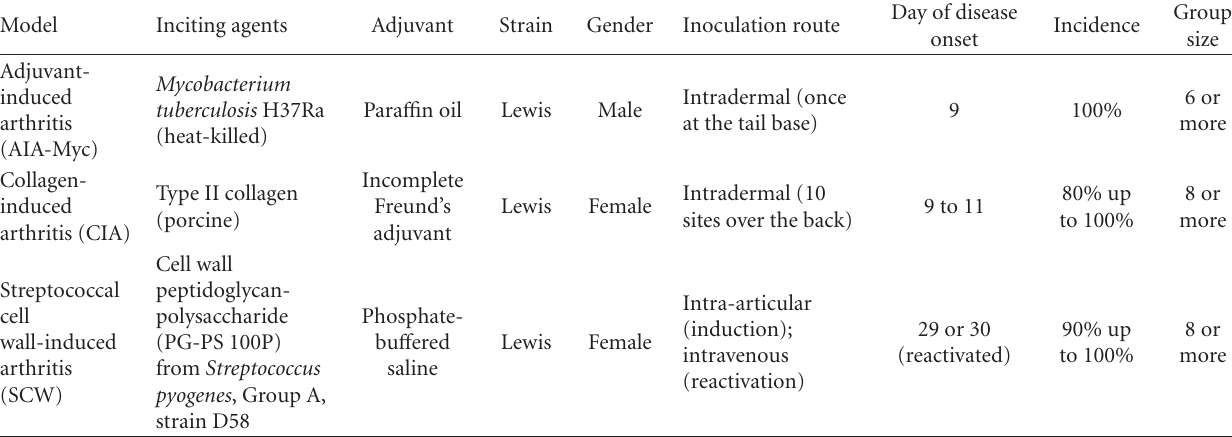
Table 2: Initiation of major induced rat models of immune-mediated arthritis commonly used in preclinical development. Model